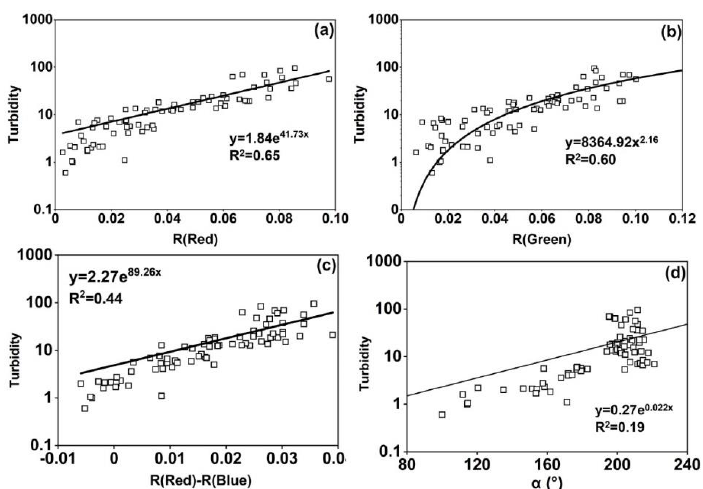
Figure 7. Models between measured turbidity and ( a ) red band reflectance, ( b ) green band reflectance, ( c ) red and blue band difference, and ( d ) chromaticity angle.